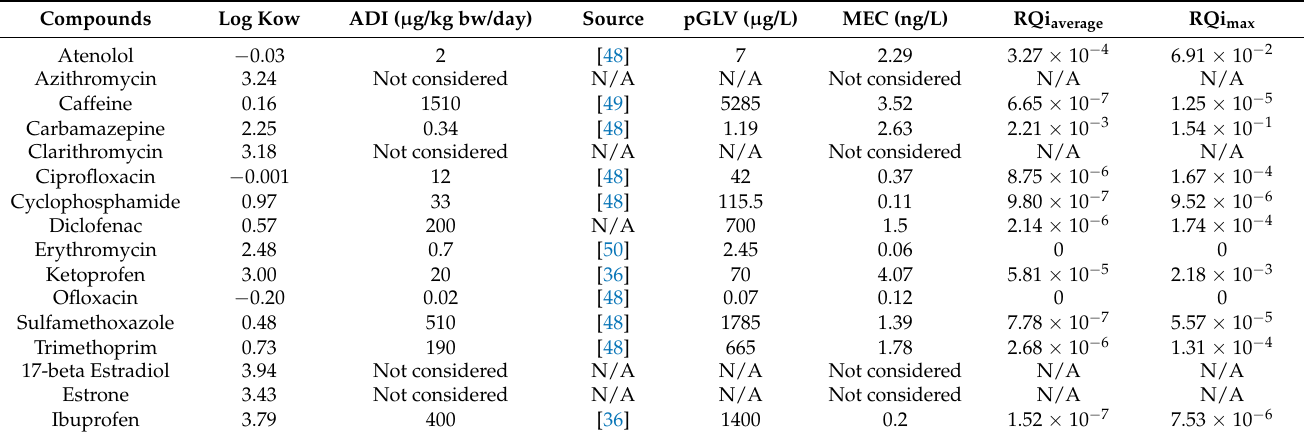
Table 3. Human health risk assessment parameters for target PhACs in raw water